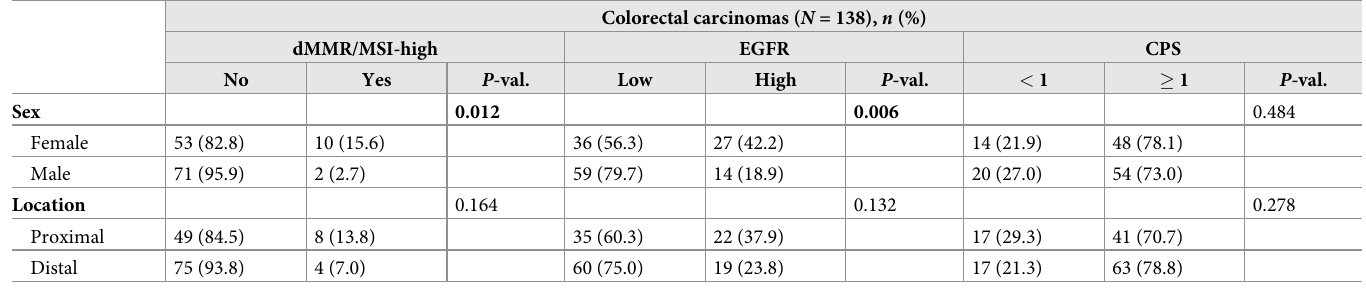
Table 4. Univariate analysis of sex or tumor location on dMMR/MSI, EGFR, and PD-L1 CPS in patients with CRC.